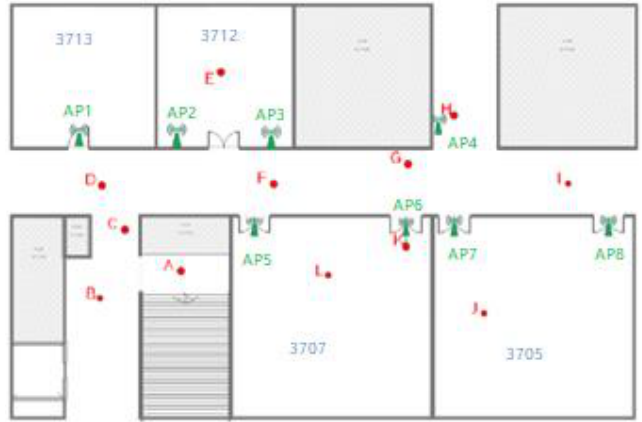
Figure 4. Distribution of modelling points.